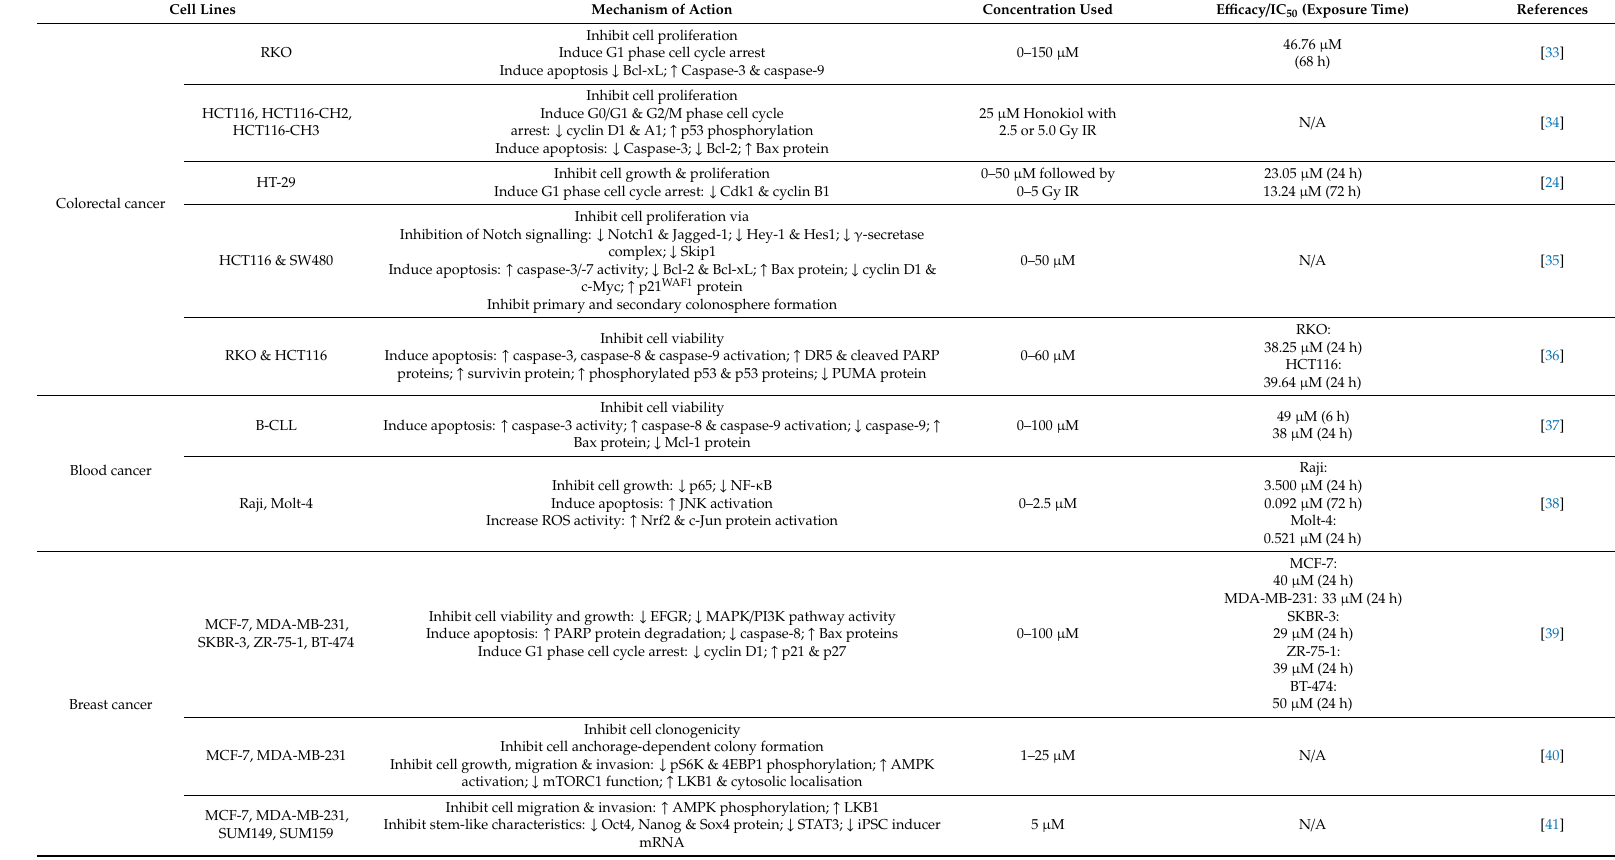
Table 1. The anticancer e ff ects of honokiol against cancer cells in in vitro